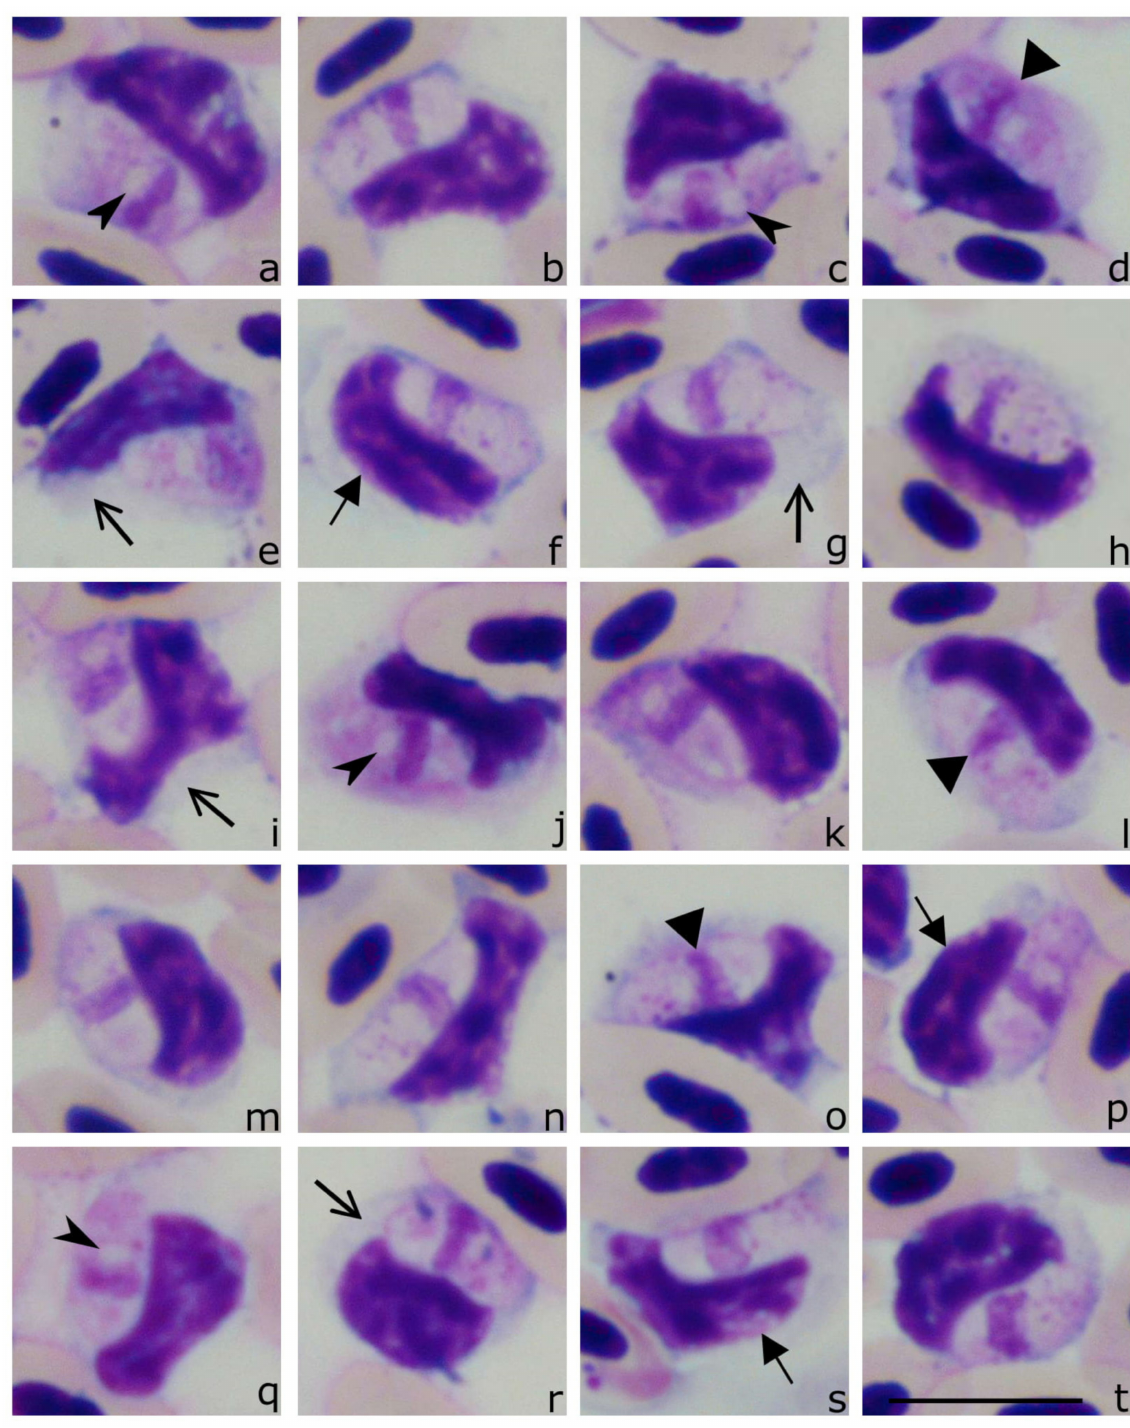
Figure 4. Sporozoites ( a – t ) of Lankesterella vacuolata n. sp. 18S rRNA lineage LanDeli1 from the common house martin Delichon urbicum . Parasites develop in mononuclear leukocytes, which are readily distinguishable from other leukocytes due to basophilic staining of the cell cytoplasm ( e , g , i , r ). Note that sporozoites are closely appressed to the host cell nuclei, which frequently assume comma-like shapes ( b , f , i , m , n , p ). A vacuole-like structure is small, does not adhere to the parasite nucleus ( a , c , j , q ); the latter is elongate and occupies the entire width of the sporozoite ( d , l , o ). Triangle, parasite nucleus. Barbed arrow, vacuole-like structure. Short triangle arrow, host cell nucleus. Simple wide arrow, host cell cytoplasm. Scale bar: 10 µ m. Methanol fixed and Giemsa-stained blood